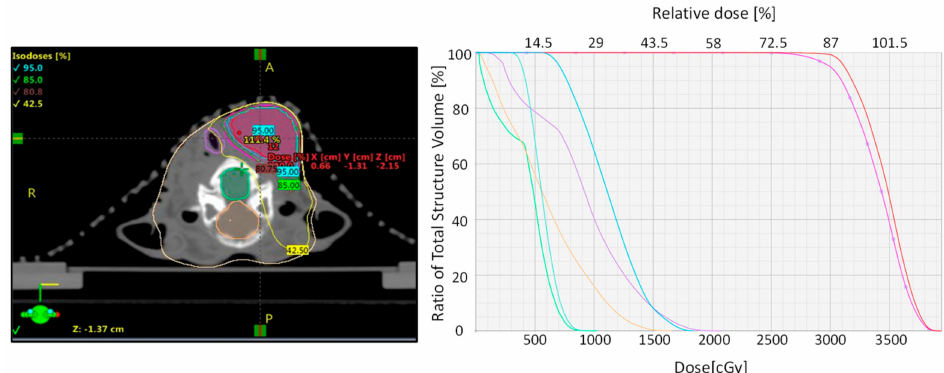
Figure 4. Dose distribution map and dose volume histogram of VX2 tumors. Dose distribution map for tumor volume and OAR displayed as isodoses (%) is shown on the left. Corresponding dose volume histogram (DVH) for radiation dose to PTV (pink), GTV (red), right and left parotid glands (blue), spinal cord (green), brain (orange), and trachea (purple) is shown on the right. Table 1. Planning target volume dosimetric parameters generated through DVH analysis